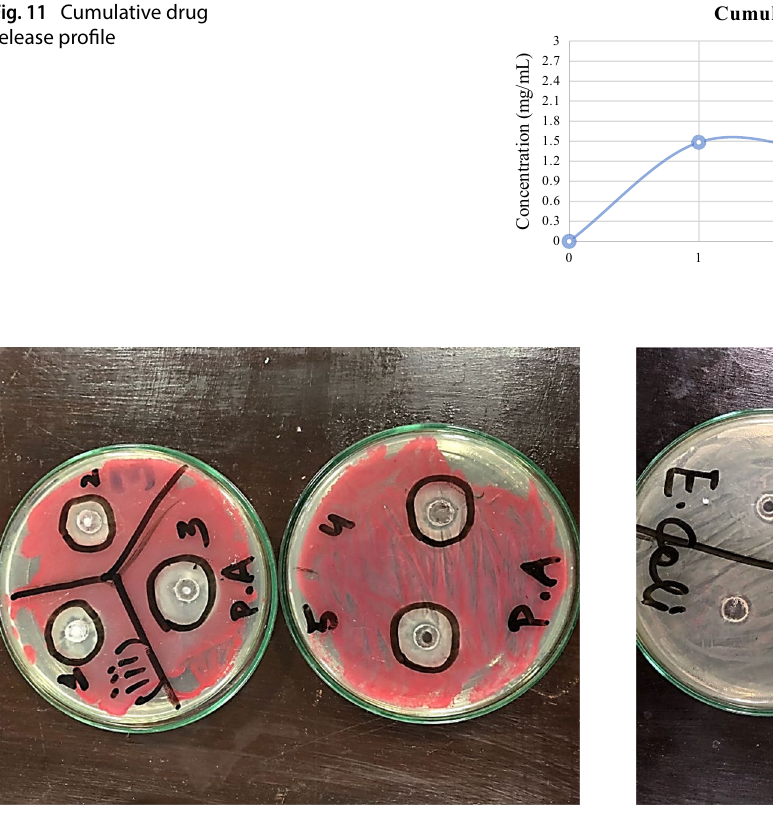
Fig. 12 Zone of inhibition of P. aeruginosa Fig. 13 Zone of inhibition of E. coli